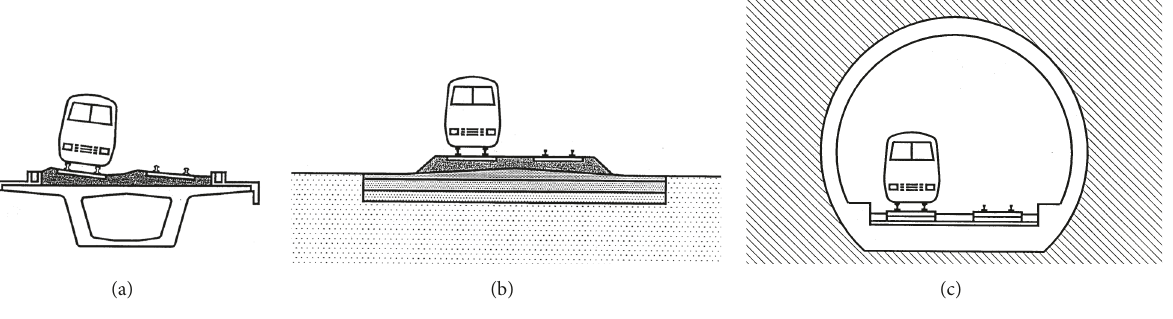
Figure 1: Simultaneous measurements at a surface, bridge, and tunnel line.